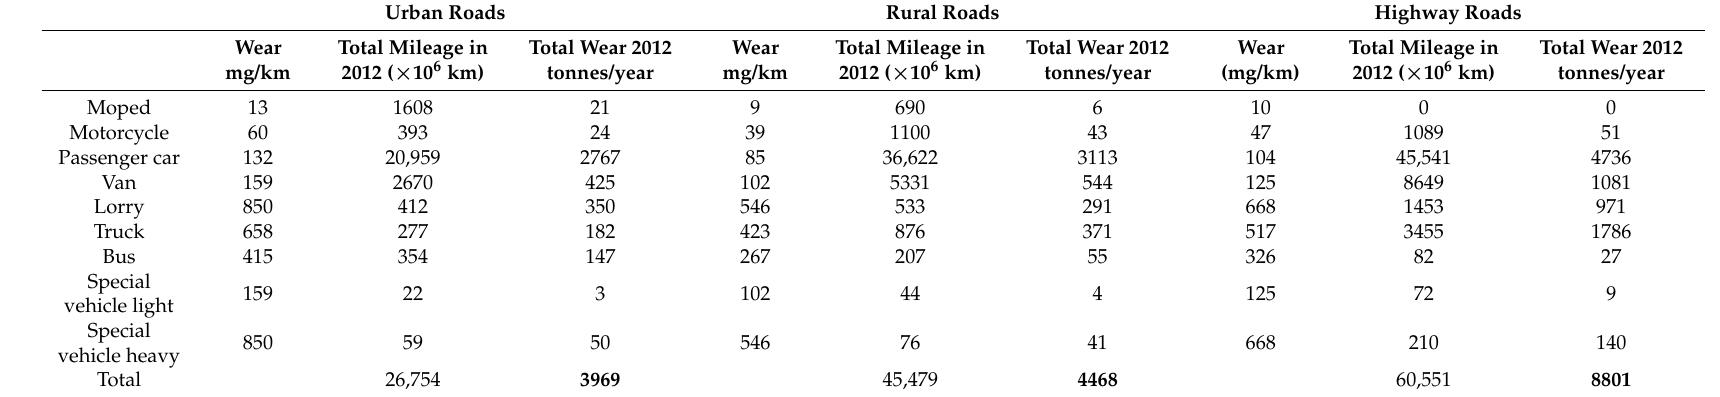
Table 2. Calculation of the amount of tyre wear and tear for urban, rural and highway roads in The Netherlands by Verschoor and colleagues [31]. Urban Roads Rural Roads